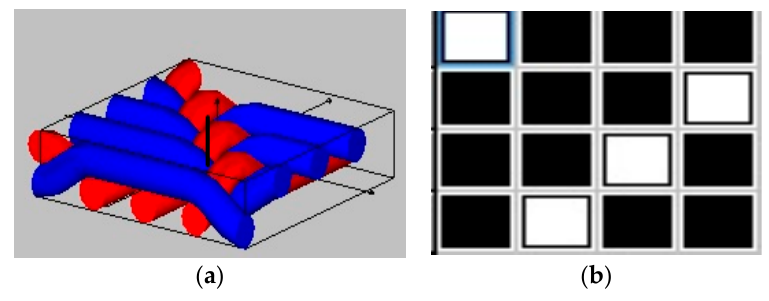
Figure 1. Weave structure: ( a ) 3D pattern, ( b ) graphical pattern. The samples were developed with the parameter levels as given in Table 2. Table 2. The factors and their